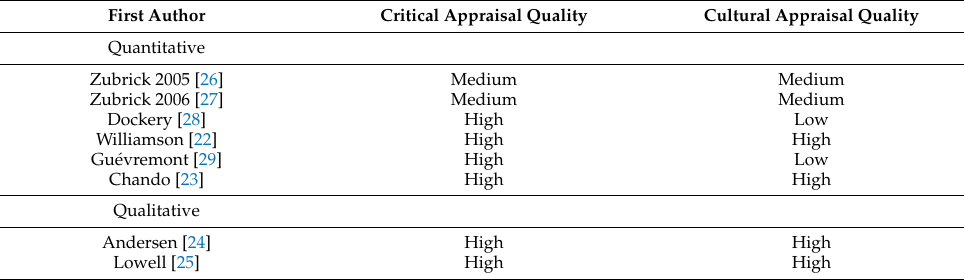
Table 3. Critical and cultural appraisal of the included studies (n =